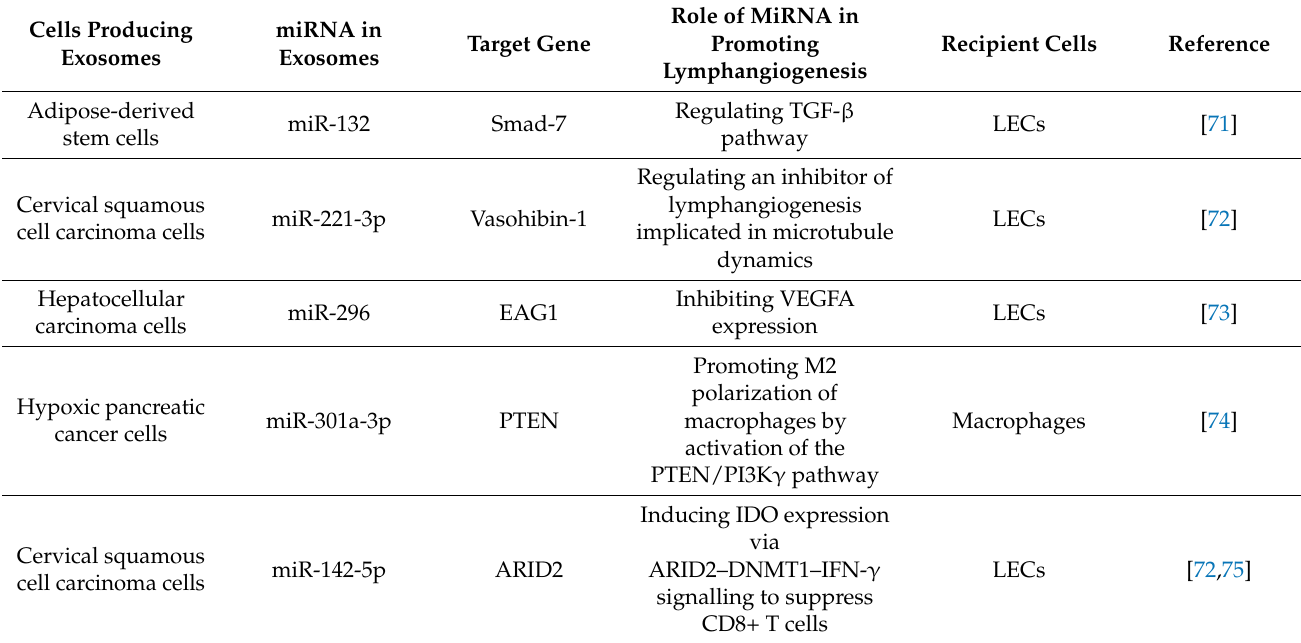
Table 1. Regulation of Lymphatic Remodelling by exosome-derived